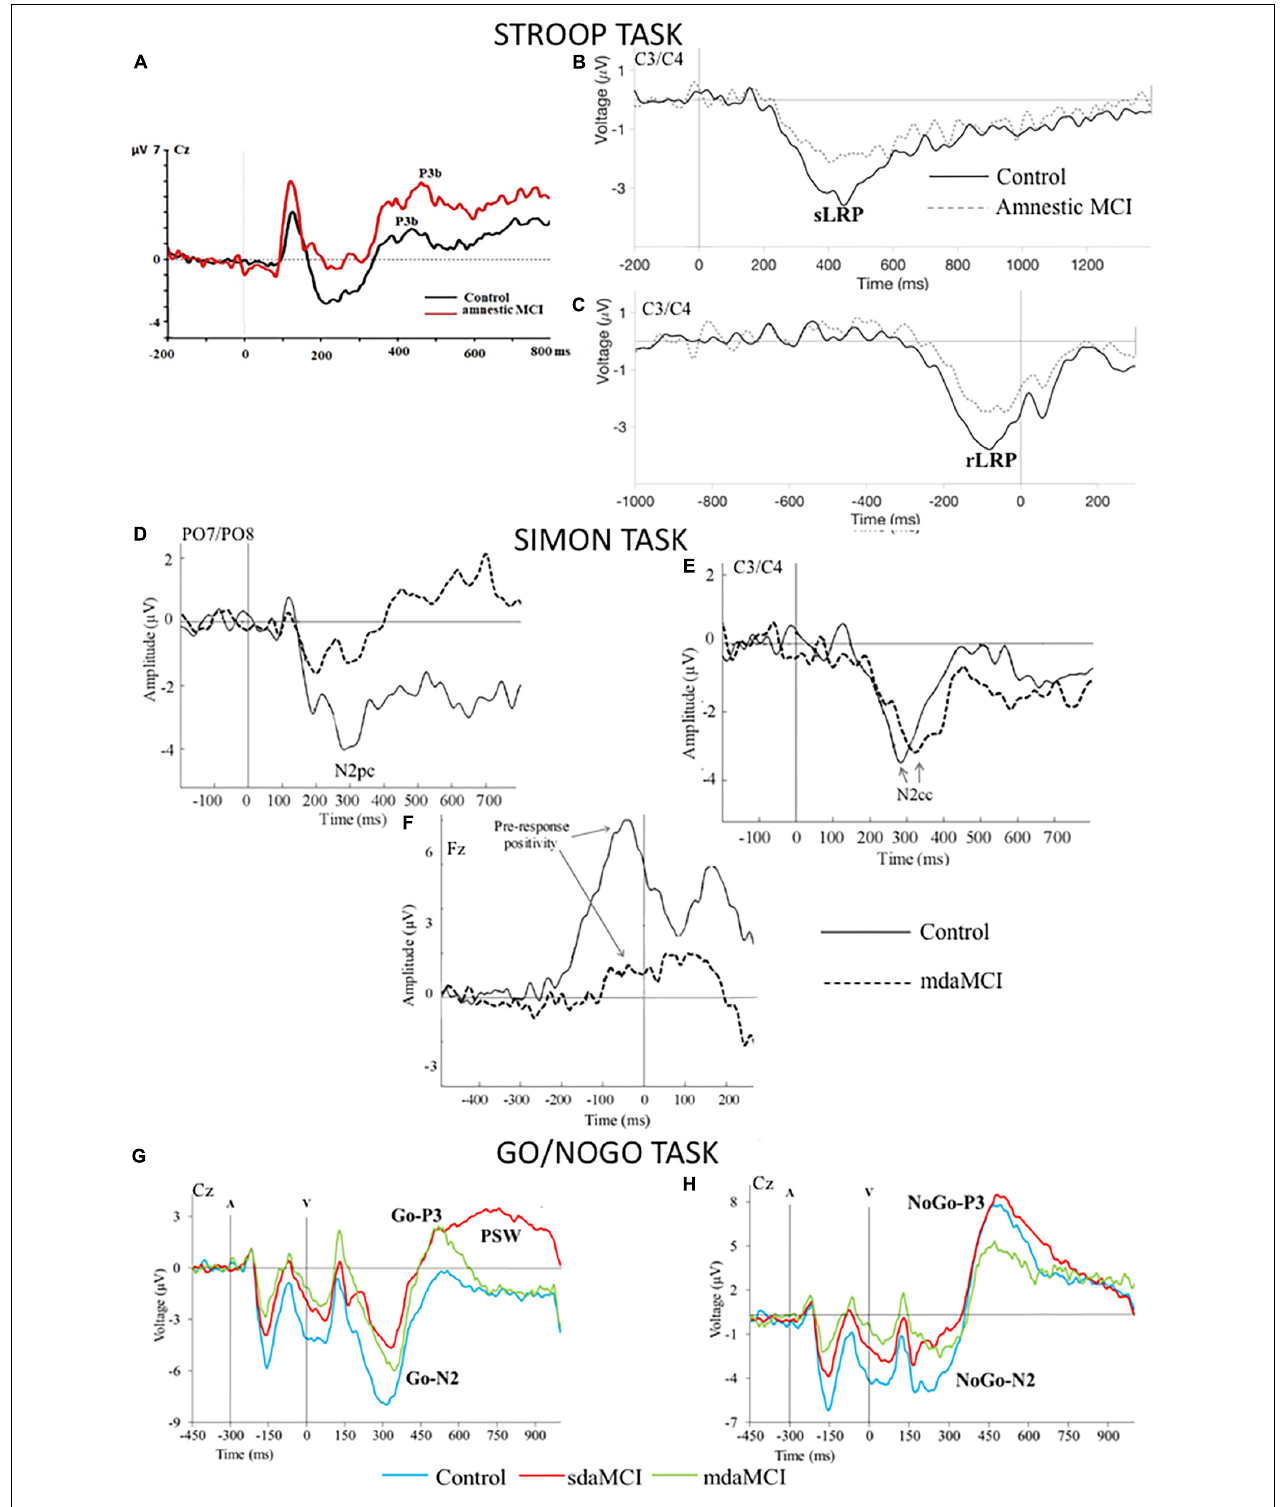
FIGURE 2 | Grand average Event-Related Brain Potentials (ERPs) waveforms elicited by (A) the incongruent stimuli in the Stroop task, (B,C) the response processing in the Stroop task [ (B) the 0 ms point corresponds to the presentation of the stimulus, (C) the 0 ms point corresponds to the emission of the response], (D,E) the stimuli in the Simon task, (F) the response processing in the Simon task; the 0 ms point corresponds to the emission of the response, (G,H) the Go and NoGo visual stimuli (V) in the Go/NoGo task (A: tone prior to visual stimulus).